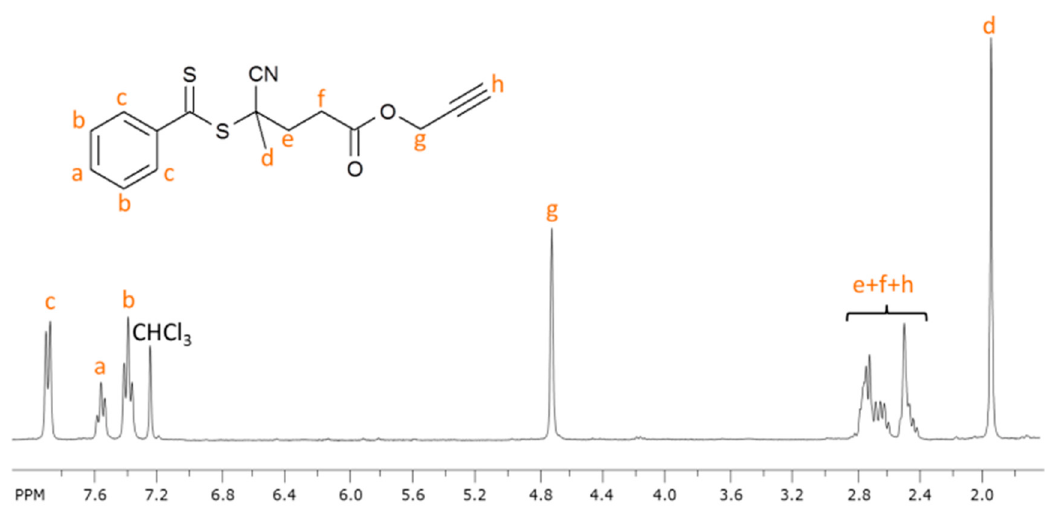
Figure 1. 1 H-NMR spectrum of 4-cyano-4(phenylcarbonothioylthio) pentanoic acid (CPADB)-Alk.